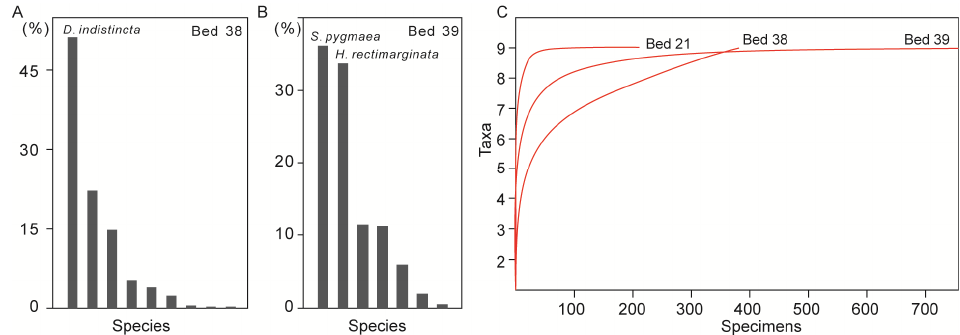
Figure 12. ( A , B ), frequency distribution of brachiopods from bed 38 (nine species) and bed 39 (seven species) in the Datuguan section; ( C ), results of rarefaction analysis of brachiopod data from three main beds yielding brachiopods in the Datuguan section. D : Dioristella ; S : Spirigerellina ; H : Hirsutella .